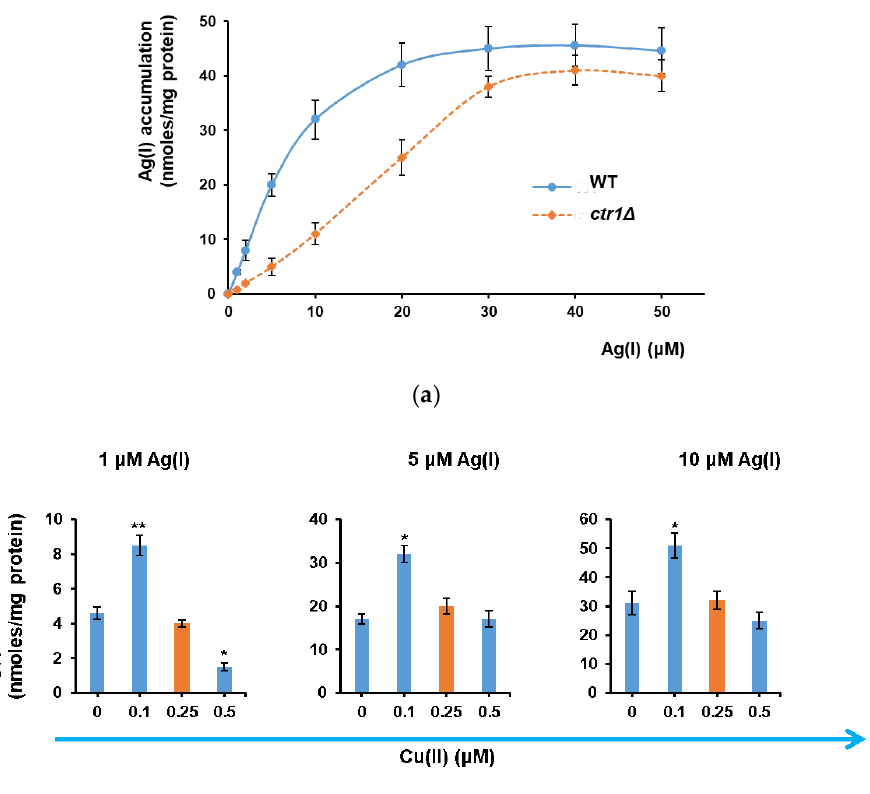
Figure 2. Ag(I) accumulation by S. cerevisiae cells . WT cells prepared as described in Materials and Methods were grown to 5 × 10 6 cells/mL before Ag(I) was added to the specified concentration. Incubation (30 °C, 200 rpm) continued for 2 h before cells were harvested and subjected to metal assay. ( a ) Effect of CTR1 deletion on Ag(I) accumulation. ( b ) Effect of Cu(II) depletion on Ag(I) accumulation by WT cells. Cu(II) drop-out MM was supplemented with increasing concentrations of Cu(II). The normal concentration of Cu(II) in MM is 0.25 µM (red bars). Asterisks indicate that the mean Ag(I) accumulation is significantly different from the mean Ag(I) accumulation under normal 0.25 µM Cu(II), according to one sample t test. * p < 0.05; ** p < 0.01.